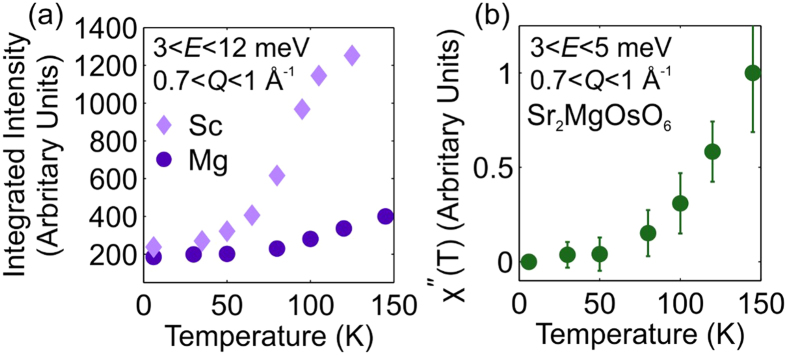
(a) Comparison of the evolution of normalized per Os integrated neutron scattering intensity of Sr2MgOsO6 and Sr2ScOsO6 and (b) the temperature dependence of the scattering within the gap of Sr2MgOsO6, converted to χ″ as in ref. 10.